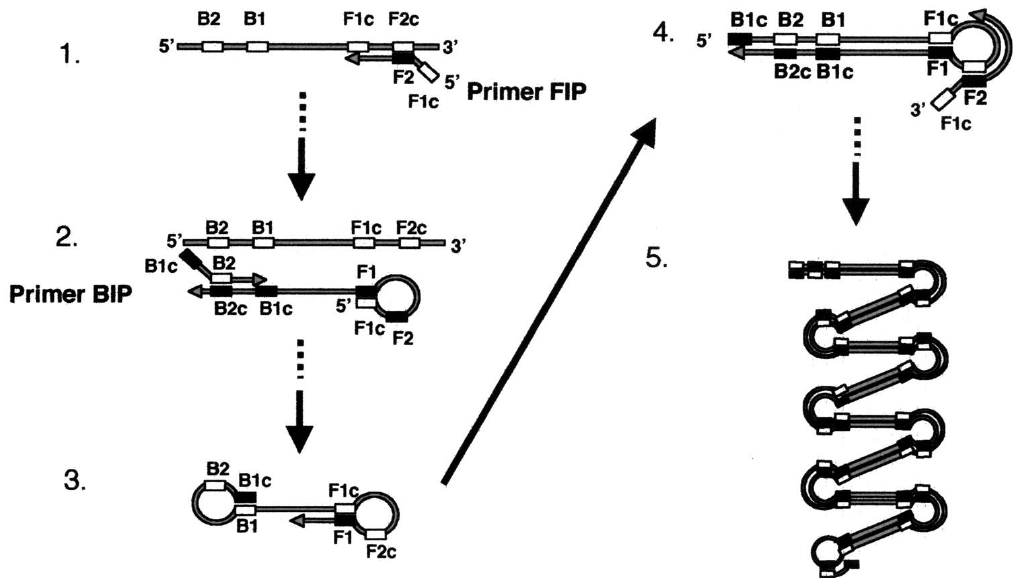
Figure 14. Loop-mediated isothermal amplification (LAMP). Reprinted from [94] with permission © American Society for